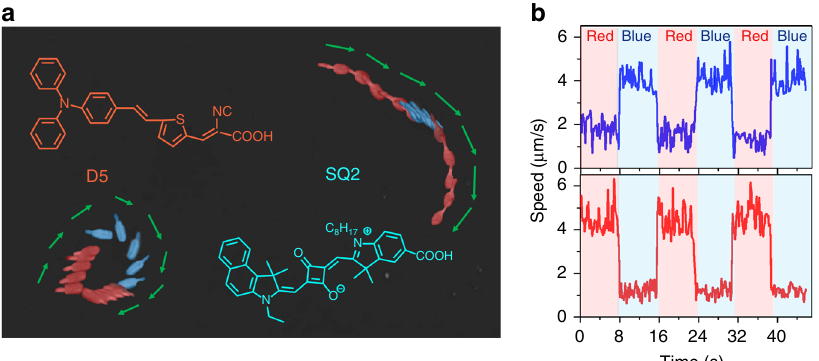
Fig. 3 The orthogonal photoresponse of the dye-sensitized microswimmers. a The superimposed image of the sequential frames shows the migration of D5 and SQ2 sensitized microswimmers under blue (475 nm) and red (660 nm) light alternating illumination (Supplementary Movie 1). Inserts: the molecular structures of D5 and SQ2 dye. b The migration speed of D5 (blue curve) and SQ2 (red curve) sensitized microswimmers in a under the alternating light